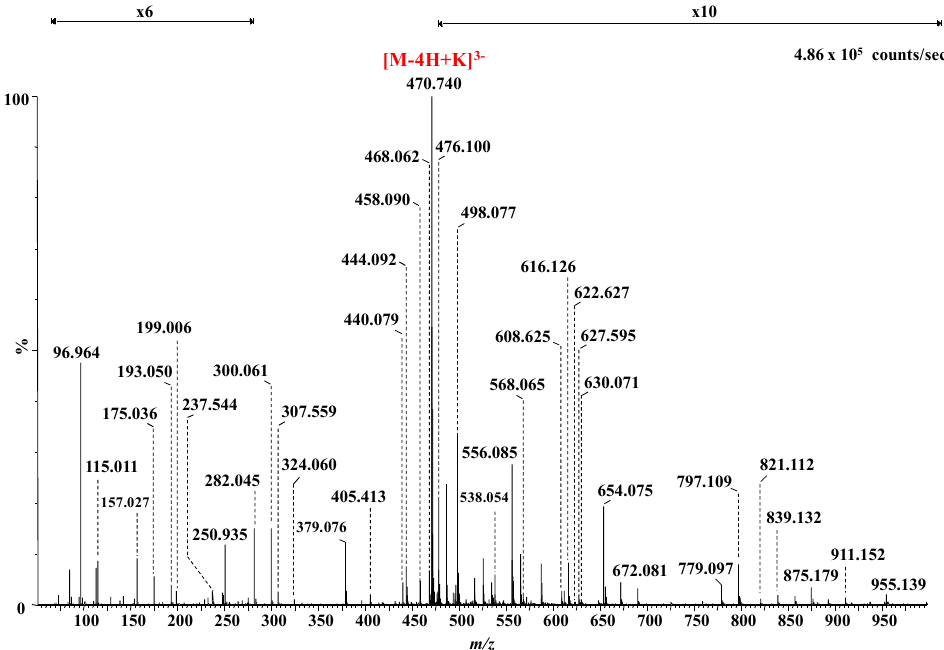
Figure 6. IMS MS of the precursor ion at m/z 470.714 fragmented by CID: ( a ) drift time distribution; ( b ) extracted mass spectra at the three mobility features: 3.67 ms, 2.08 ms, and 1.73 ms. The IMS CID MS/MS of the ion at m/z 470.714 is presented in Figure 7 whereas the fragment ions together with their assignment are listed in Table 2.